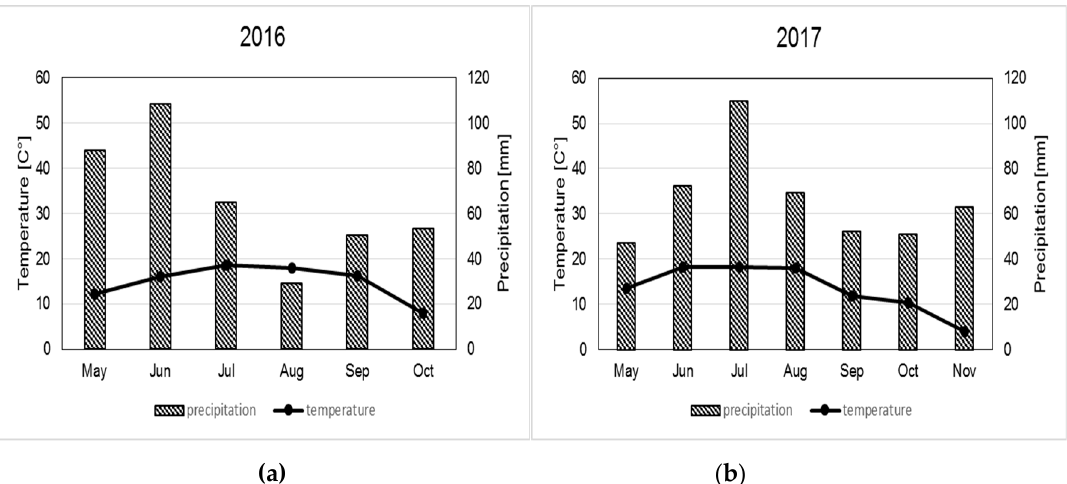
Figure 1. Temperature ( • ) and precipitation (bars) at the trial site, Ihinger Hof for the cultivation period of yacon in ( a ) 2016 and ( b ) 2017. Plotted are the average temperatures in degree Celsius, and the total rainfall in mm in each month. Temperature and precipitation in May and October (2016) and May and November (2017) only include the days, which were within the cultivation period.